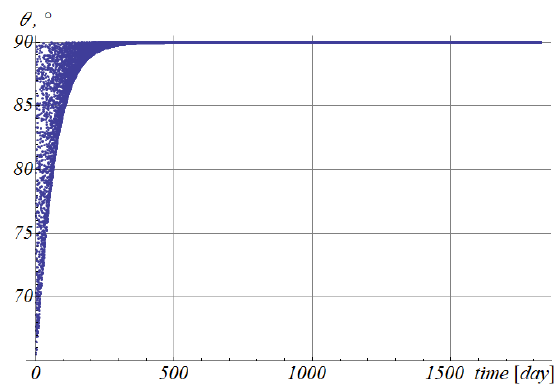
Figure 4. Transition to “flat” spin shown by the angle θ vs